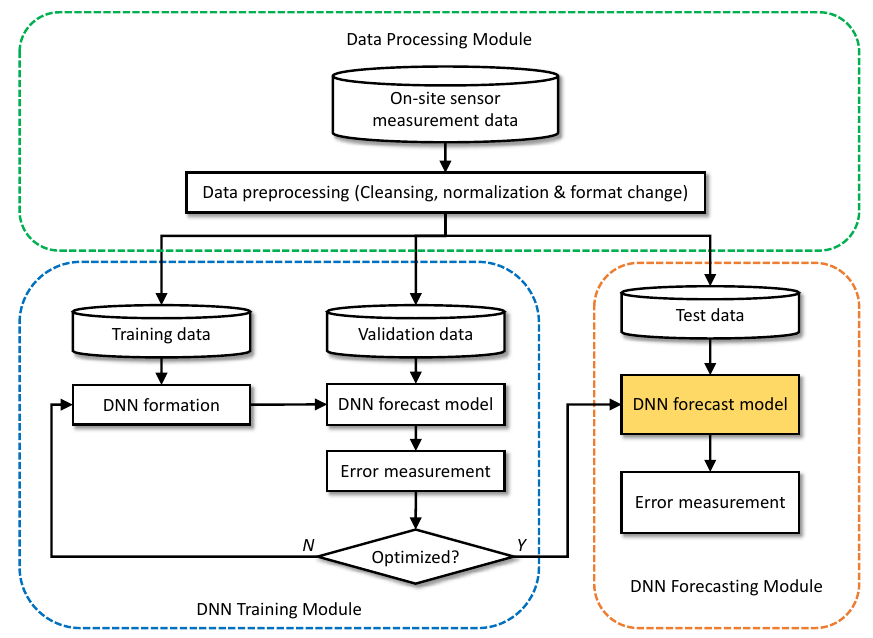
Figure 3. Training and testing process used in this paper.